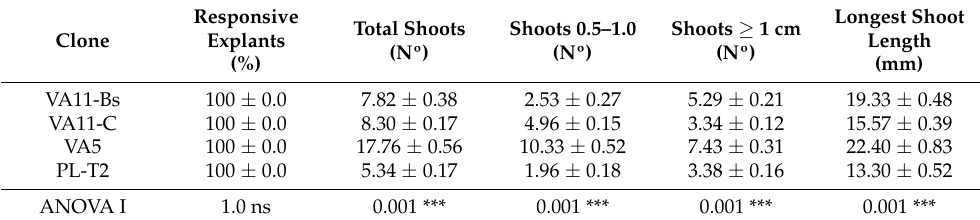
Table 3. Effect of genotype and/or ontogenic origin on in vitro shoot multiplication of adult trees of Q. ilex